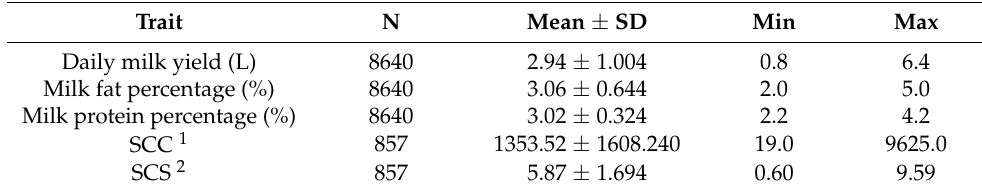
The descriptive statistics of the analysed traits are shown in Table 3. Table 3. Descriptive statistics of goat milking traits of analysed data (mean ± standard deviation).